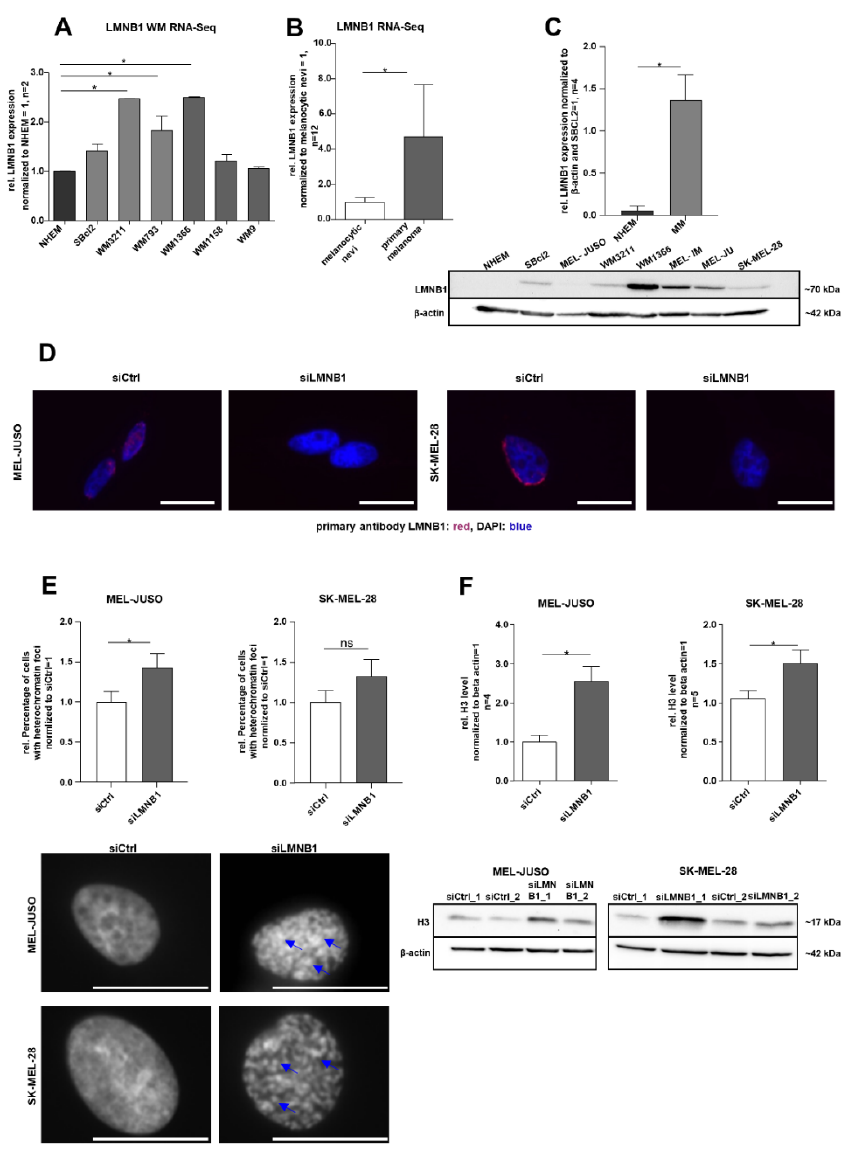
Figure 1. ( A ) RNA sequencing analysis of LMNB1 expression in different Wistar melanoma (WM) cell lines compared to NHEMs (one-way ANOVA and subsequent Tukey’s multiple comparison test). ( B ) RNA sequencing analysis of LMNB1 expression in the primary melanoma compared to melanocytic nevi (one-way ANOVA and subsequent Tukey’s multiple comparison test). ( C ) Western blot analysis of LMNB1 protein expression in NHEMs and various melanoma cell lines (Student’s t -test). ( D ) Representative images of immunofluorescence LMNB1 staining in MEL-JUSO and SK- MEL-28 transfected with siLMNB1 and siCtrl for 72 h. Scale bars equal 20 µ m. ( E ) DAPI staining of MEL-JUSO and SK-MEL-28 cells transfected with siLMNB1 and siCtrl for 72 h. Visible heterochro- matin foci marked with blue arrows. Statistical analysis was performed using Student’s t -test. Scale bars equal 20 µ m. ( F ) Western blot analysis of the H3 level following 72 h treatment with siLMNB1 and siCtrl in MEL-JUSO and SK-MEL-28 using β -actin as a housekeeper (Student’s t -test). Bars represent the means ± SEM (* = p ≤ 0.05, ns = not